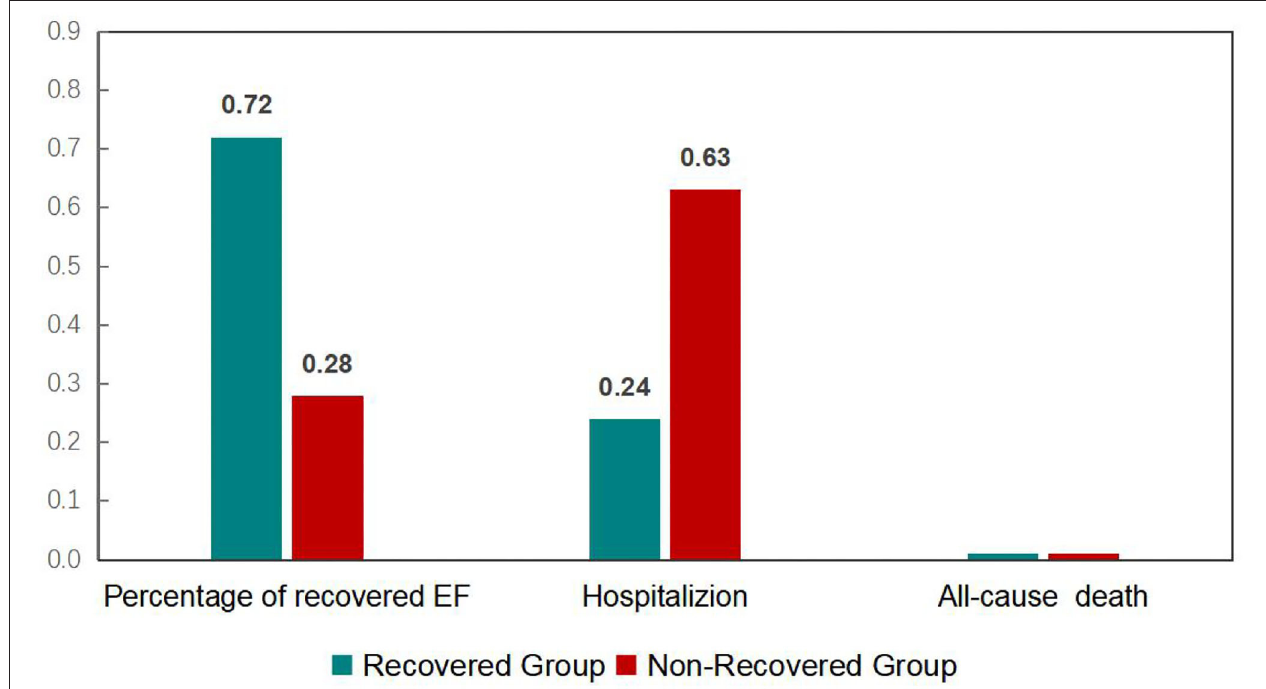
FIGURE 1 | Recovery and outcome of heart failure patients undergoing atrial fibrillation after a one-year follow-up.